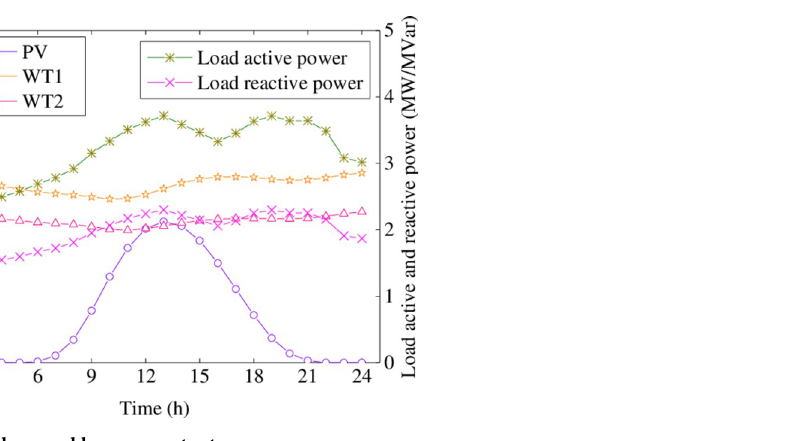
Fig 3. Load and renewable energy output curves.